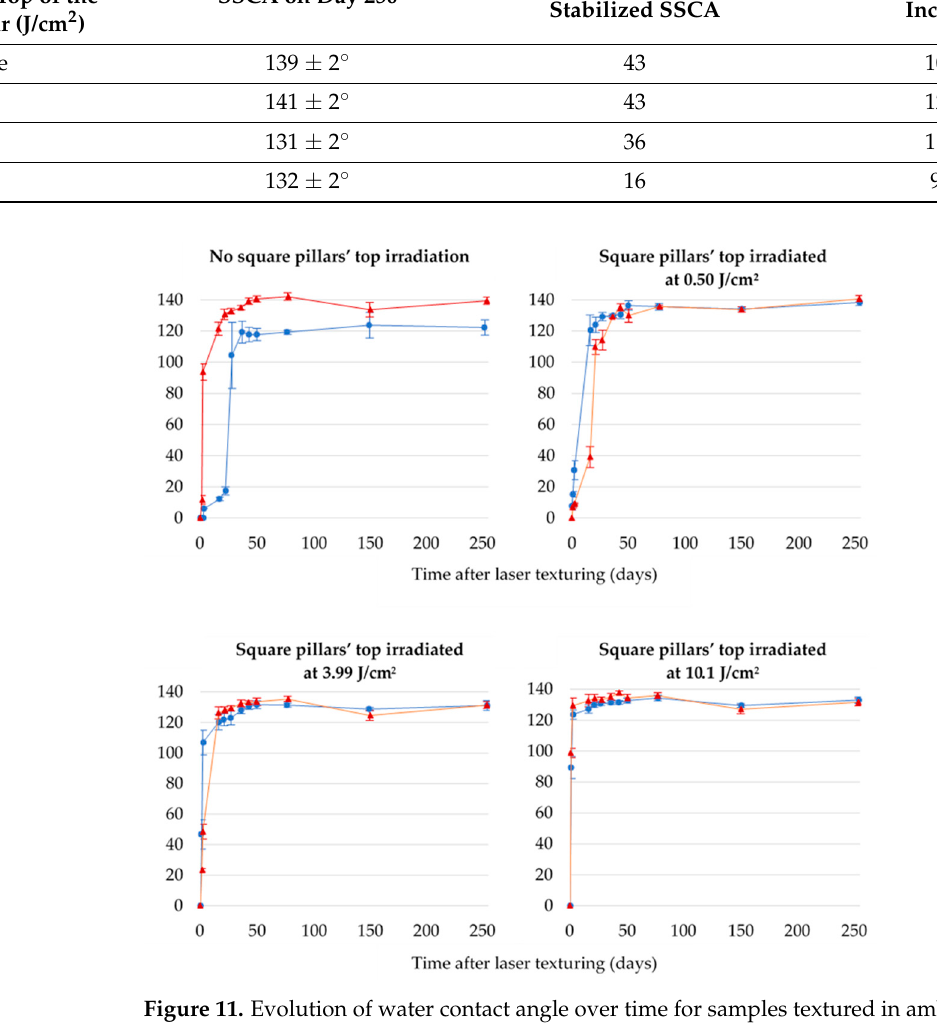
Figure 11. Evolution of water contact angle over time for samples textured in ambient air or under a CO 2 flow using different fluences to irradiate the square pillars’